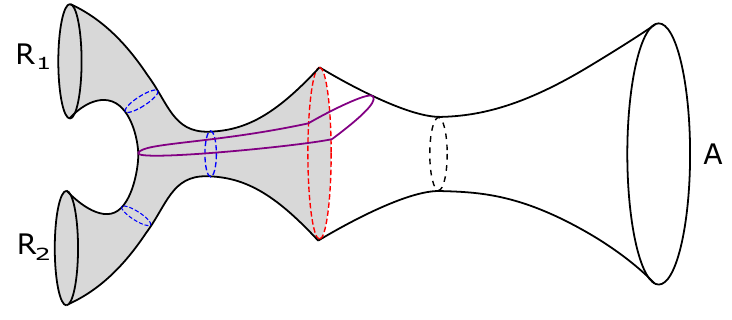
Figure 9 . The puri(cid:12)cation of the inception disk by a three boundary wormhole with two radiation legs R 1 and R 2 . The red dashed line is the EOW brane position, the rest of the dashed lines are causal horizons. There is a new RT surface drawn in purple that is homologous to R 1 and involves part of the total island that is between the EOW position and the horizon of the real black hole A